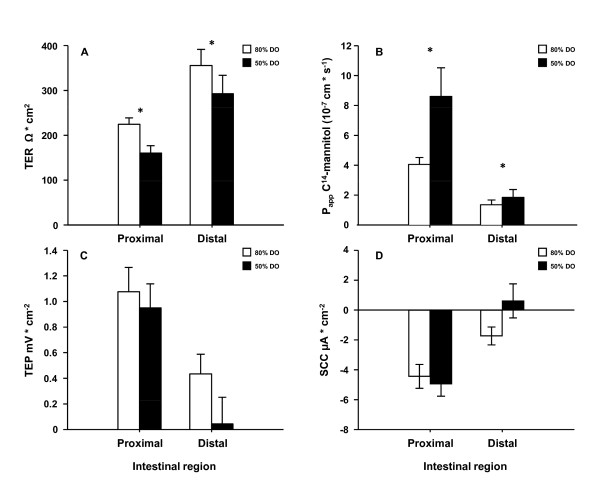
Intestinal barrier function after long term hypoxia (Experiment 1). This experiment aimed at mimicking an overall situation often found in sea cages when water flow decreases and DO levels are reduced to levels as low as around 50%. Decreased water exchange rate may also cause increased concentrations of toxic metabolites. Four fish from each tank in triplicate was sampled between days 41-43, from 80% and 50% DO levels groups created by adjusting inflow (range 41-137 L min-1) in response to oxygen consumption of the fish. The intestine was removed and opened longitudinally, divided into a proximal and a distal part, washed in ice-cold salmon Ringer solution and mounted in Ussing chambers. The electrical parameters; transepithelial resistance (TER), short-circuit current (SCC) and transepithelial potential (TEP) were measured. TER is mainly a measure of the paracellular permeability, and SCC describes the sum of active transports. This, together with the passive leakage of charged molecules across the epithelium is reflected in the TEP. The paracellular permeability of the intestinal epithelium was also assessed as the apparent permeability (Papp) of a well documented paracellular marker 14C-mannitol. Ussing chamber data was analysed using a genral linear model with intestinal region and treatment (with tank nested within treatment) as factors. Paracellular permeability was higher in both intestinal regions in the 50% DO group as indicated by decreased TER (p < 0.05) (A) and the increased Papp for mannitol which increased in both the proximal and distal intestine (p < 0.05) (B). No major differences were observed in TEP (C) or SCC (D). All data are expressed as means ± SEM and p < 0.05 was regarded as significant and indicated as *, p < 0.01 as ** and p < 0.001 indicated as ***.